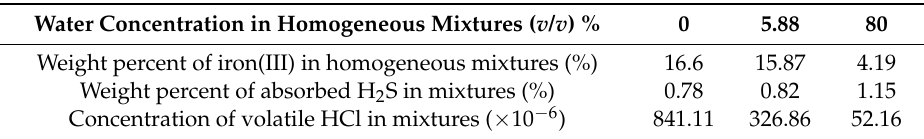
Table 1. Effect of water concentration on the weight percent of absorbed H 2 S and volatile HCl emissions in homogenous [bmim]Fe(III)Cl 4 –H 2 O mixtures at 60 ◦ C. Water Concentration in Homogeneous Mixtures ( v / v )